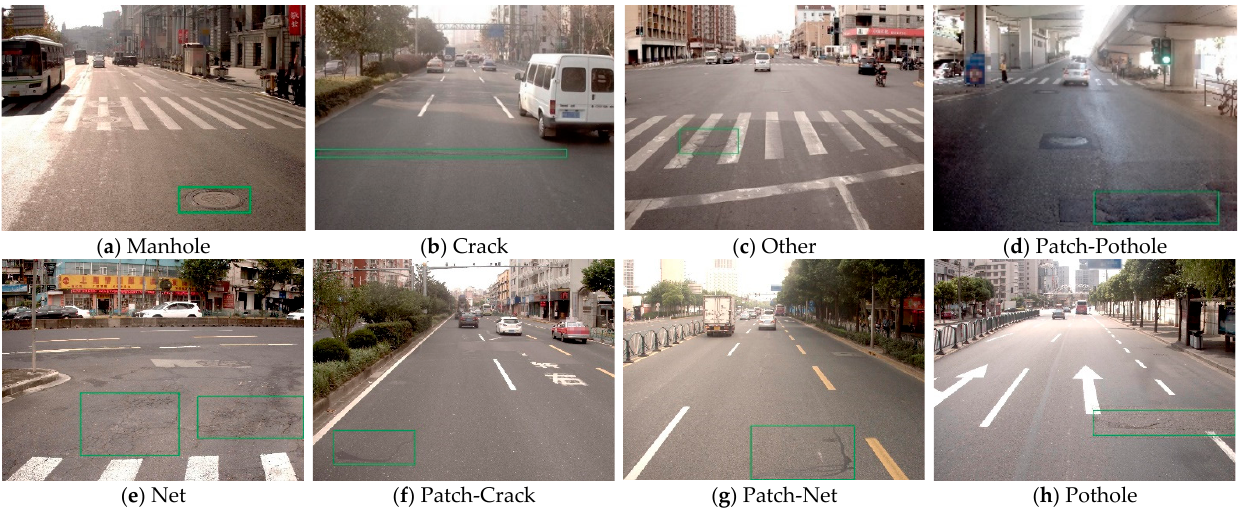
Figure 1. Example of road diseases. ( a – h ) is the shape of road diseases in the green box is irregular and the scale varies greatly. ( f – h ) is the green box contains more background information.